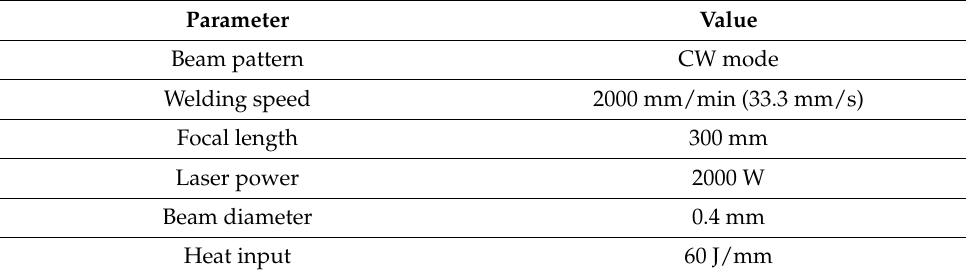
Table 1. The LBW parameters used for